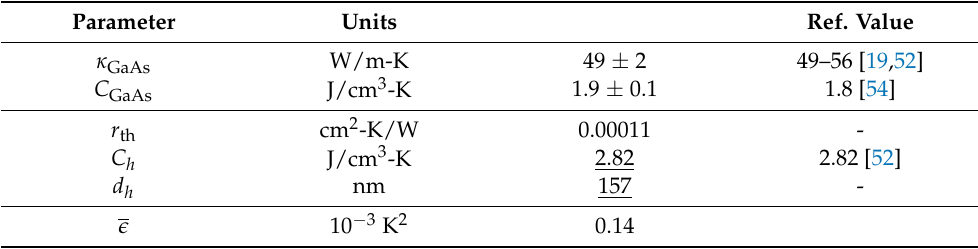
Table A4. Fitted parameter values for bulk GaAs.